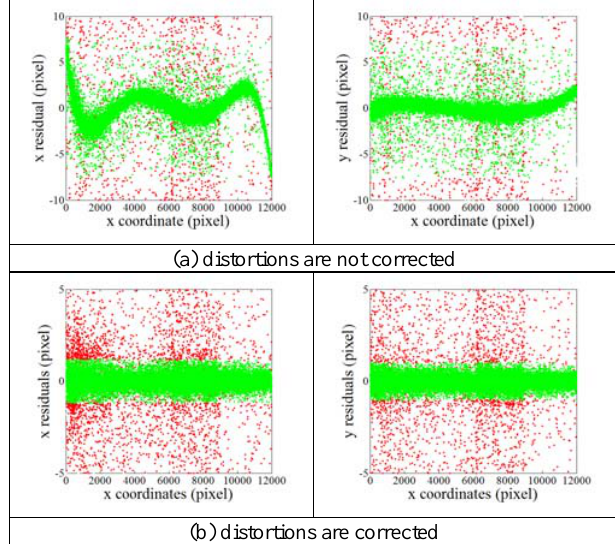
Figure 5. The distribution of the image-space residuals against x-coordinates. The red dots represent the GCPs that are eliminated as outliers, while the green dots are inliers.